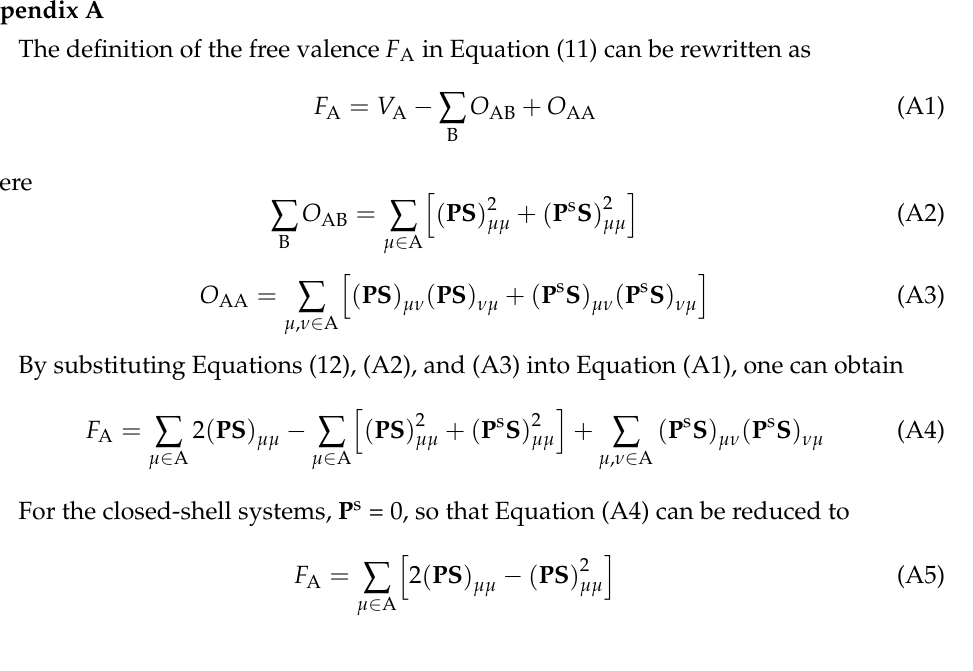
H2, Figure S2: Potential energy curves for F2, Figure S3: Potential energy curves for HF, Figure S4: Potential energy curves for N2, Figure S5: Potential energy curves for C2, Table S1: Comparison of different indexes and λ values of diatomic molecules in equilibrium distances, Table S2: Comparison of different indexes and λ values of the molecules in the AE6 dataset, Table S3: Comparison of different indexes and λ values of several atoms in the second row, Table S4: Comparison of different indexes and λ values of the transition states in the DBH24